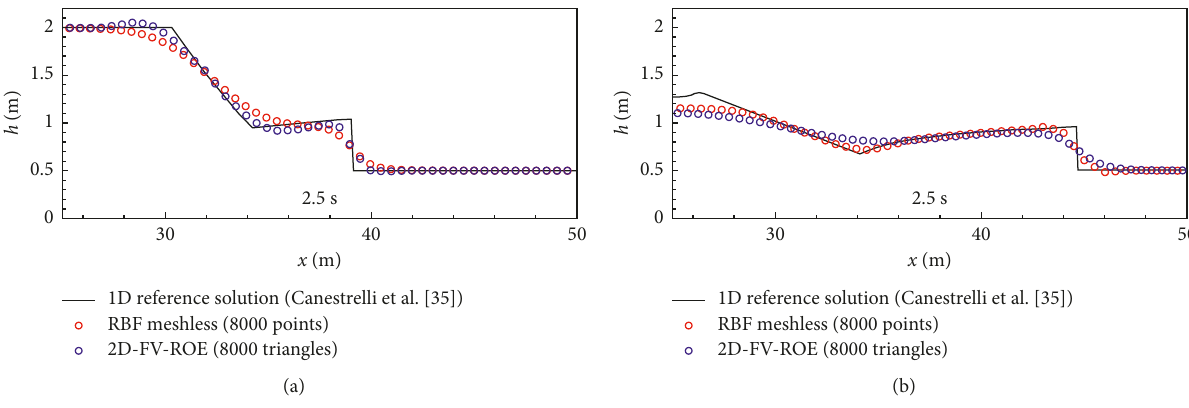
Figure 7: Cross section comparison between the numerical solution using the RBF meshless method and 2D FV-Roe scheme and the 1D reference